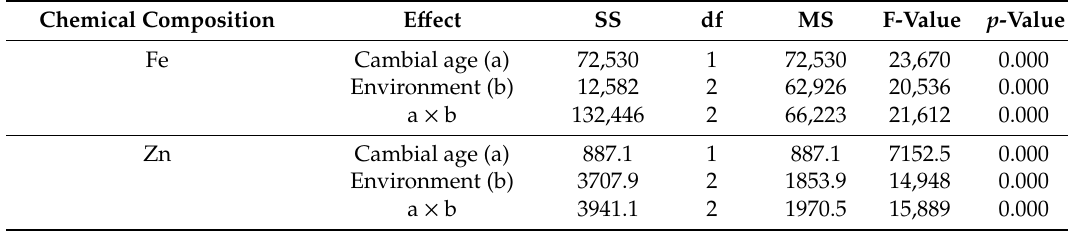
Table 3. Two-factor ANOVA tables for chemical composition of elements (Fe, Zn, Cu, Pb, Cd) of lime ( Tilia cordata Mill.) wood taking into account the e ff ect of cambial age and environment. Chemical